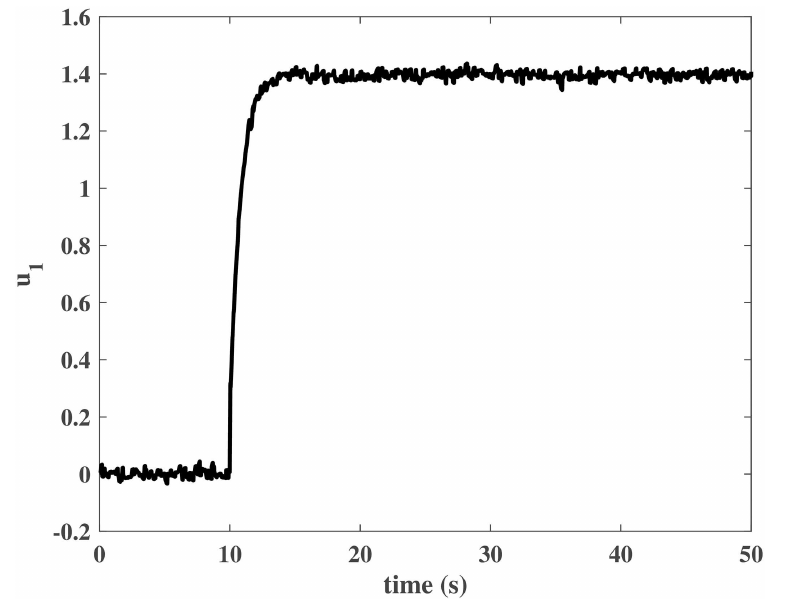
Fig 15. Controller output u 1 in the HIL simulation.